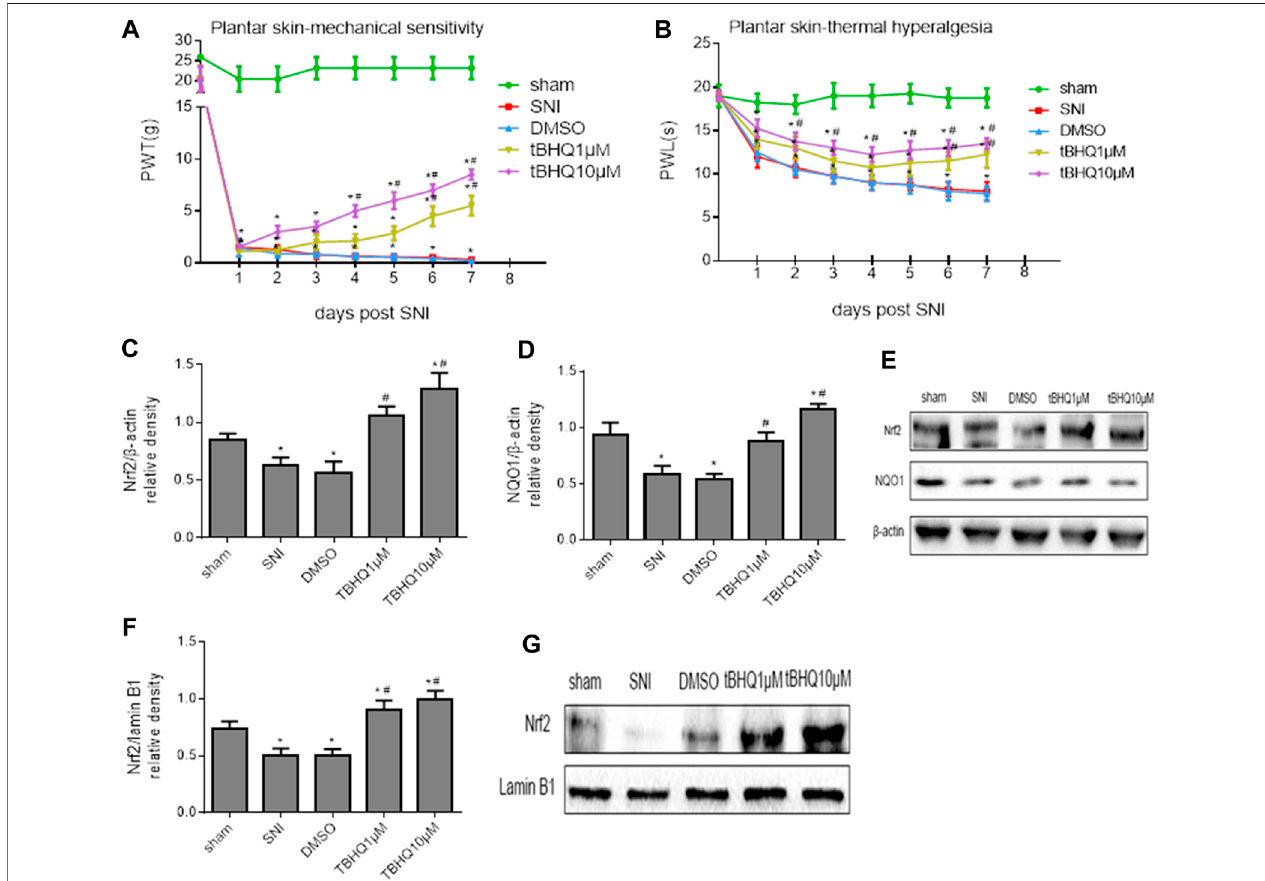
FIGURE3|(A,B) :EffectsofintrathecalinjectionofDMSO(vehicle)ordifferentdosesofNrf2agonisttBHQonmechanicalallodyniaandthermalhyperalgesiainSNI rats. (C – E) : Effects of intrathecal injection of DMSO or different doses of Nrf2 agonist tBHQ on expression of Nrf2 and its downstream target NQO1 in the whole tissue lysatesofthespinalcordinSNIrats. (F,G) :EffectsofintrathecalinjectionofDMSOanddifferentdosesofNrf2agonisttBHQonexpressionofNrf2inthenuclearfractions of the spinal cord in SNI rats. Sham rats without treatment served as control. Values are expressed as mean ± SE (n (cid:1) 4 for each group). * p < 0.05 vs sham or baseline (day 0); # p < 0.05 vs SNI or